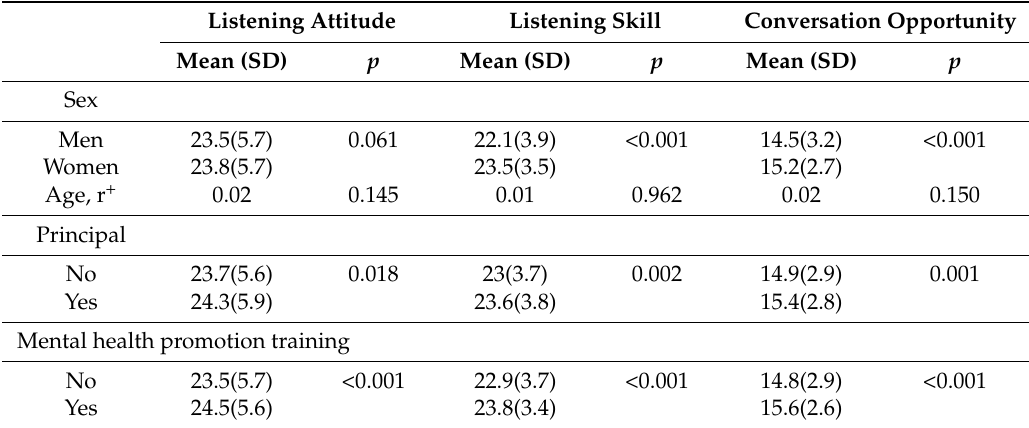
Table 4. Association of ALAS subscales with sex, age, being a principal and having received mental health promotion training.